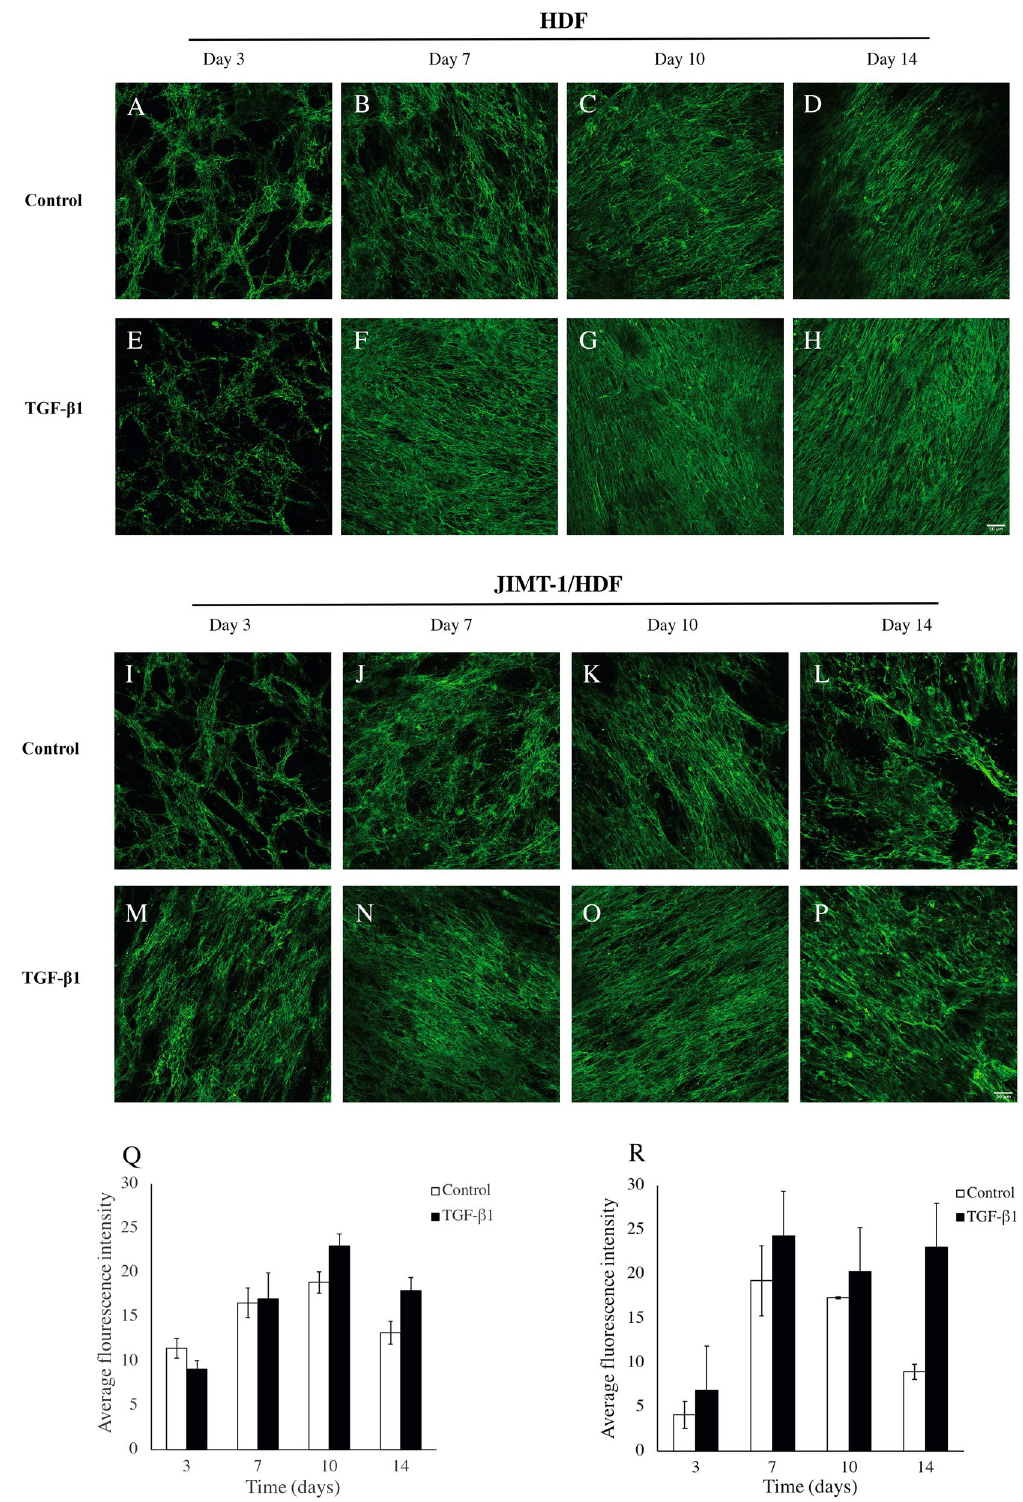
Figure 1. Fibronectin deposition, localization, and quantification in decellularized scaffolds of HDF and JIMT-1/HDF 3D cultures. ( A – P ) Single confocal plane images of fibronectin deposition taken in the centre of decellularized 3D cultures incubated in the absence (control) or presence of 5 ng/ml TGF-β1. The 3D cultures were decellularized, fixed in 3.7% formaldehyde and stained to visualize fibronectin (green) at 3, 7, 10, and 14 days of culturing. All images are representative of 3 independent experiments. Scale bar is 50 μm. Quantification of fluorescence intensity using ImageJ in images taken by epifluorescence microscopy in HDF decellularized scaffolds ( Q ) and JIMT-1/HDF decellularized scaffolds ( R ). The columns are represented as mean ± SEM (n =